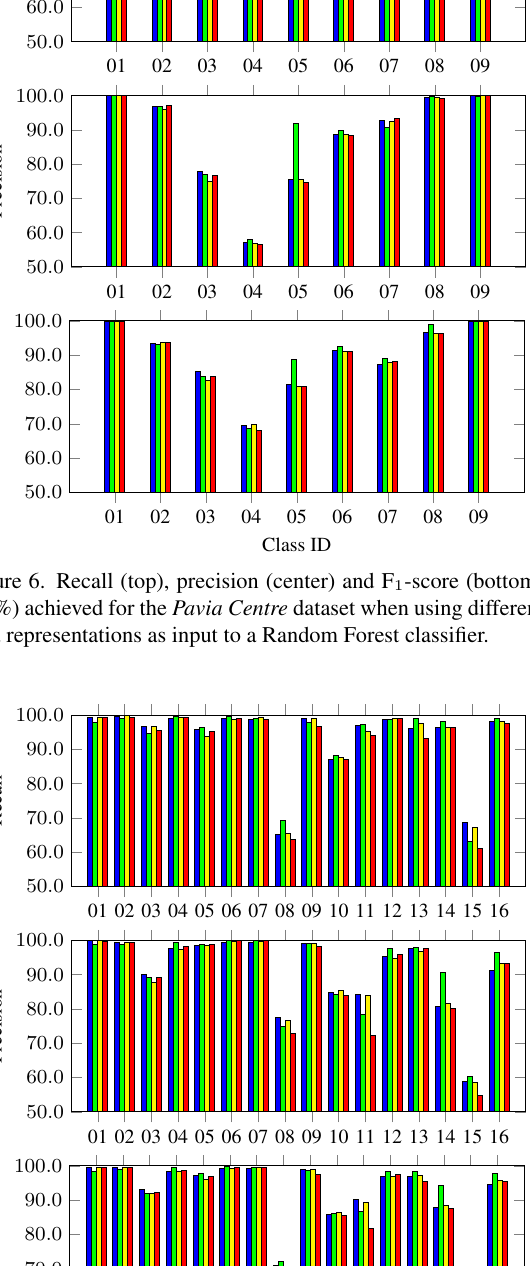
Figure 5. Classified scene for the Salinas dataset when using the original hyperspectral data (first column), the PCA-based encod- ing of hyperspectral data (second column), the CFS-based selec- tion of relevant spectral bands (third column) and the Sentinel-2- like data (fourth column) as input to a Random Forest classifier: the color encoding follows the definition in Figure 3.